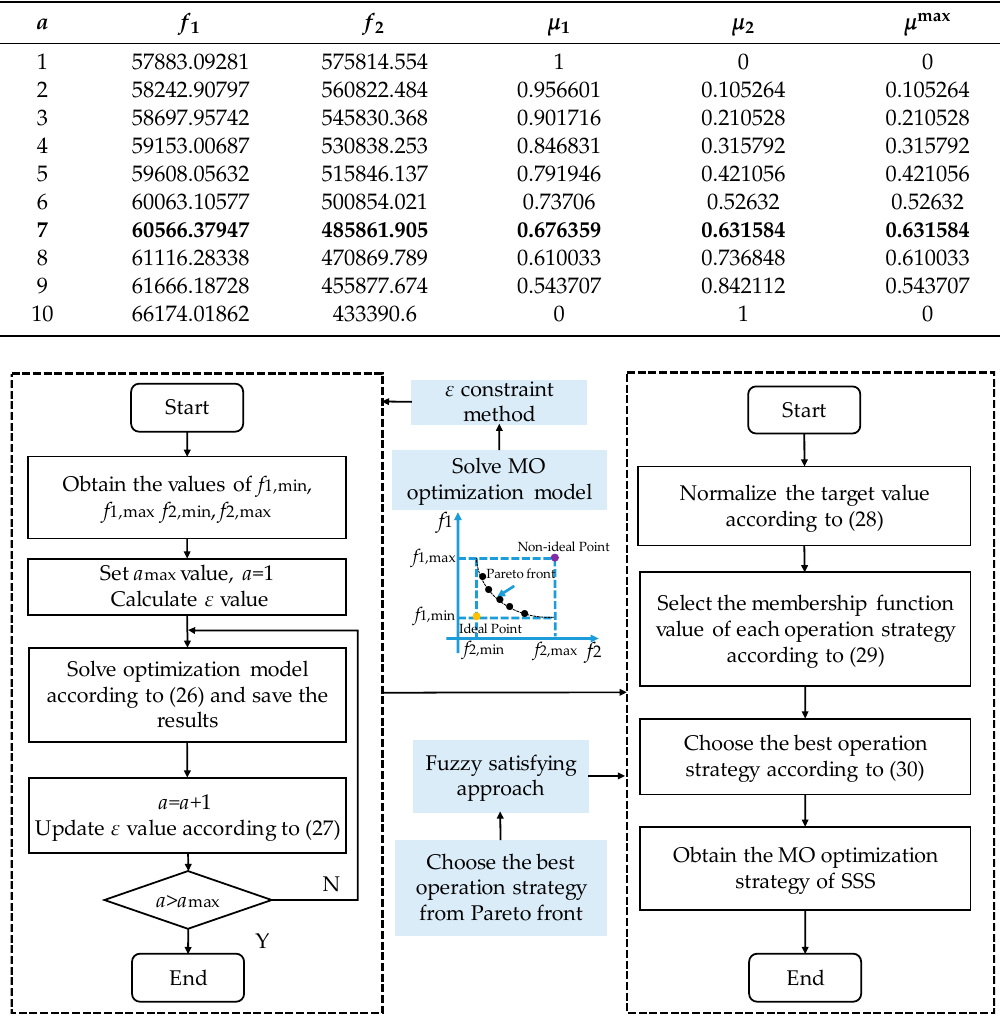
Figure 2. Flowchart of the multi-objective optimization solution